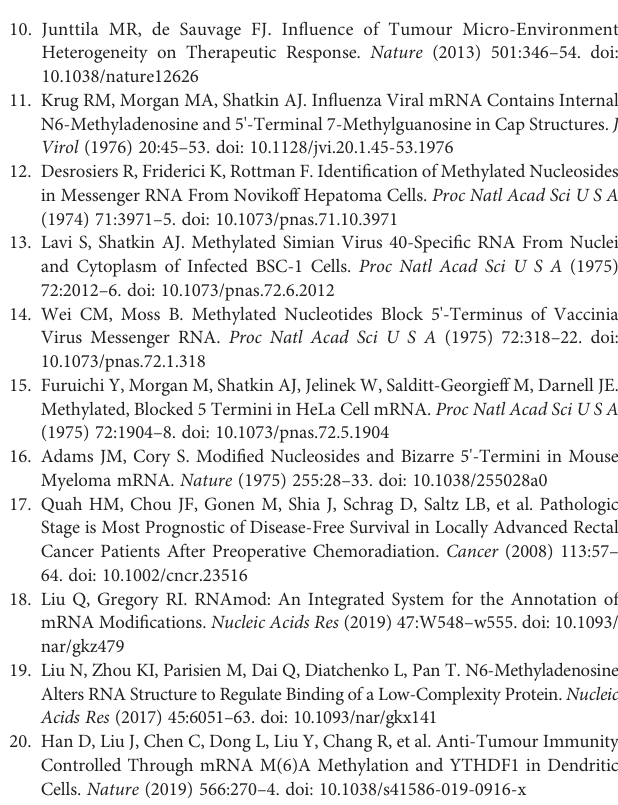
Supplementary Figure 1 | Theexpressionof23m 6 AregulatoryfactorsinZC3H13 Wild. (A – W) The upper and lower ends of the box represent a quarter of the value range. The line in the box represents the median value, and the black dots represent the outliers. Supplementary Figure 2 | Unsupervised cluster analysis of m 6 A regulatory factors. (A) Consensus matrix legend. (B – I) Consensus matrices of the TCGA and GSE87211cohortfor k = 2-9. (J) Theconsensusgraphof CDFvalue K=2-9. (K) CDF curve with CDF value K=2-9. (L) CDF value K=2-9 in the tracking plot of the